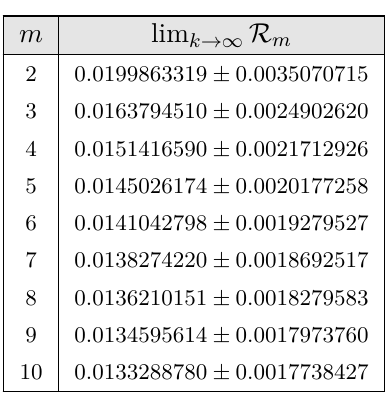
Table 13. The k → ∞ values of the Rényi entropies associated with the state | 6 2 # T 2 , 2 i .